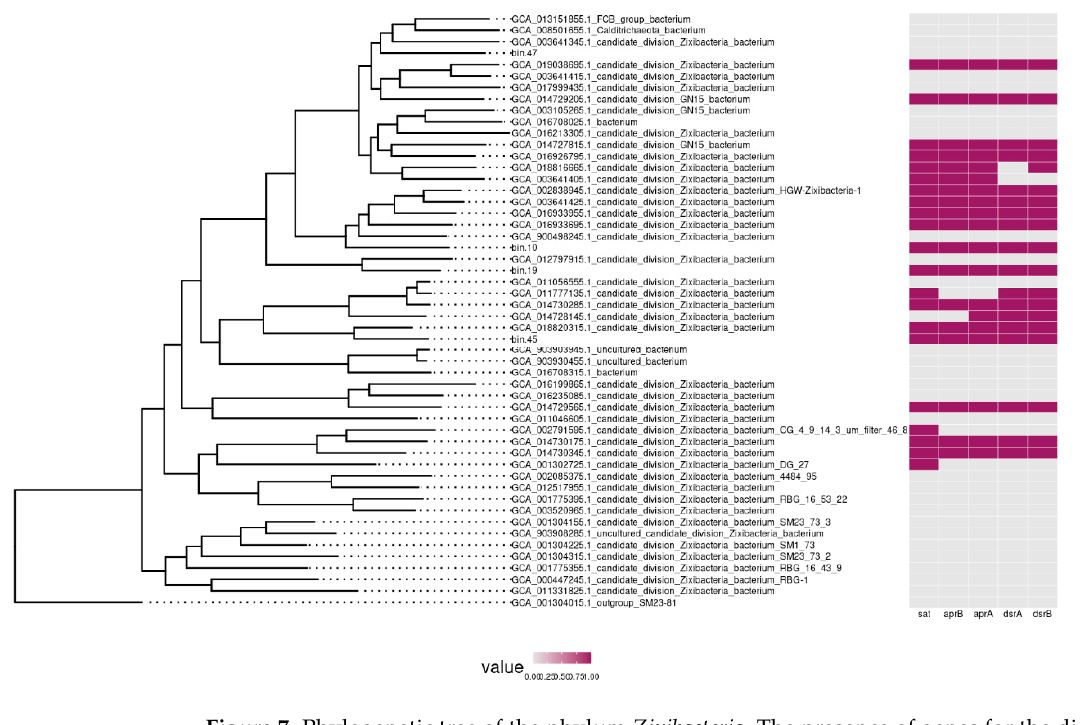
Figure 7. Phylogenetic tree of the phylum Zixibacteria . The presence of genes for the dissimilation pathway of sulfate reduction is shown to the right of the tree.